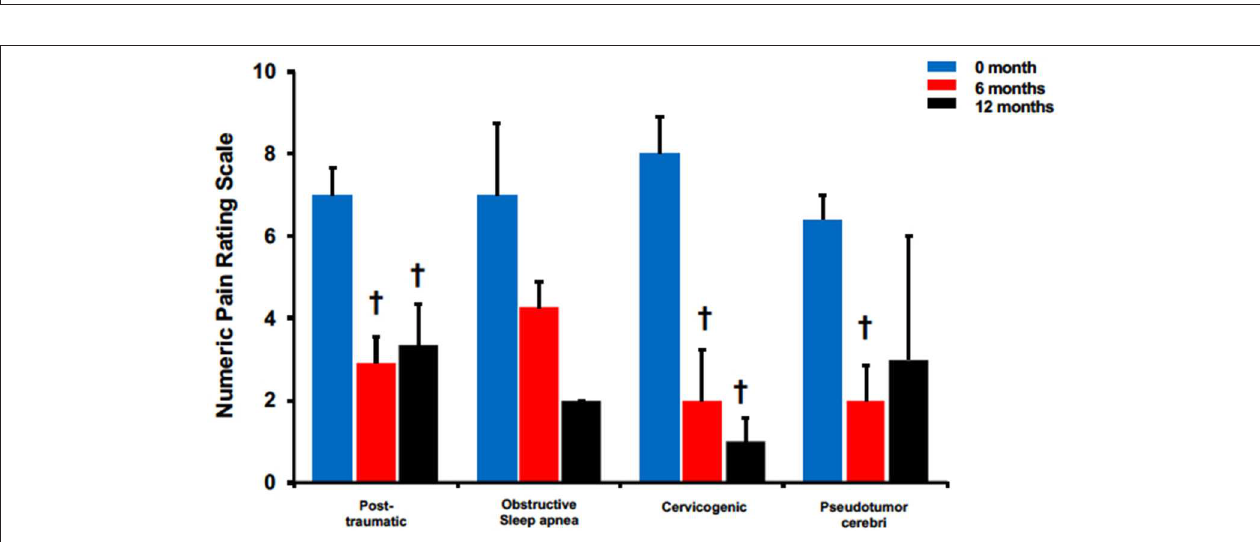
FIGURE 3 | BoNTA treatment reduced pain severity for single non-migraine headache types in a time dependent manner. n = 2–11, † p < 0.05 vs. 0